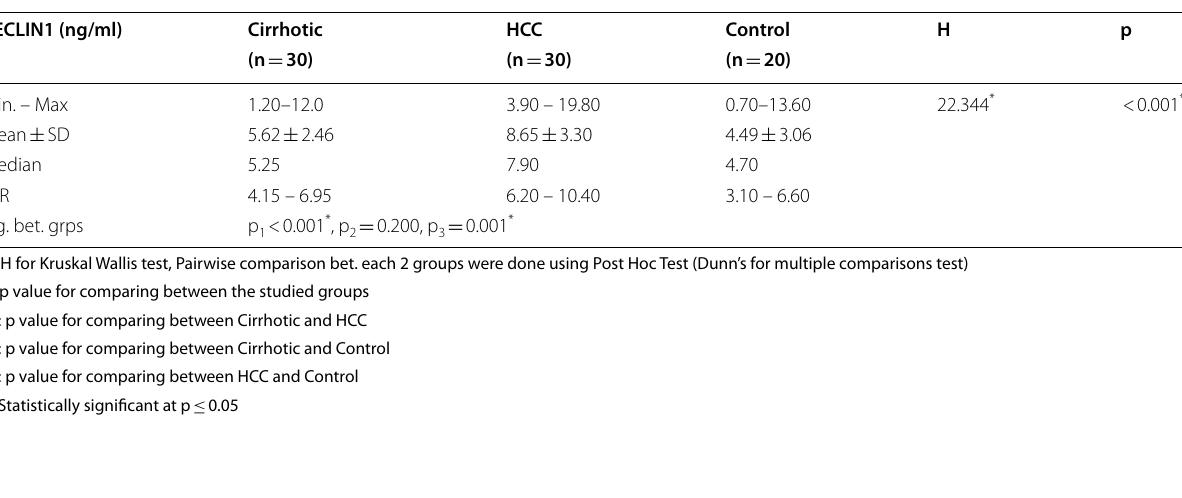
Table 6 Comparison between the three studied groups according to